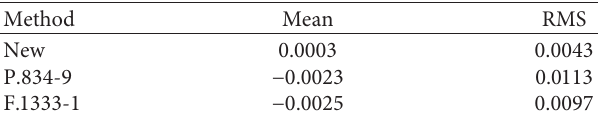
Table 4: Errors for geosynchronous orbit satellites when the geometric elevation angle is known (in degrees).